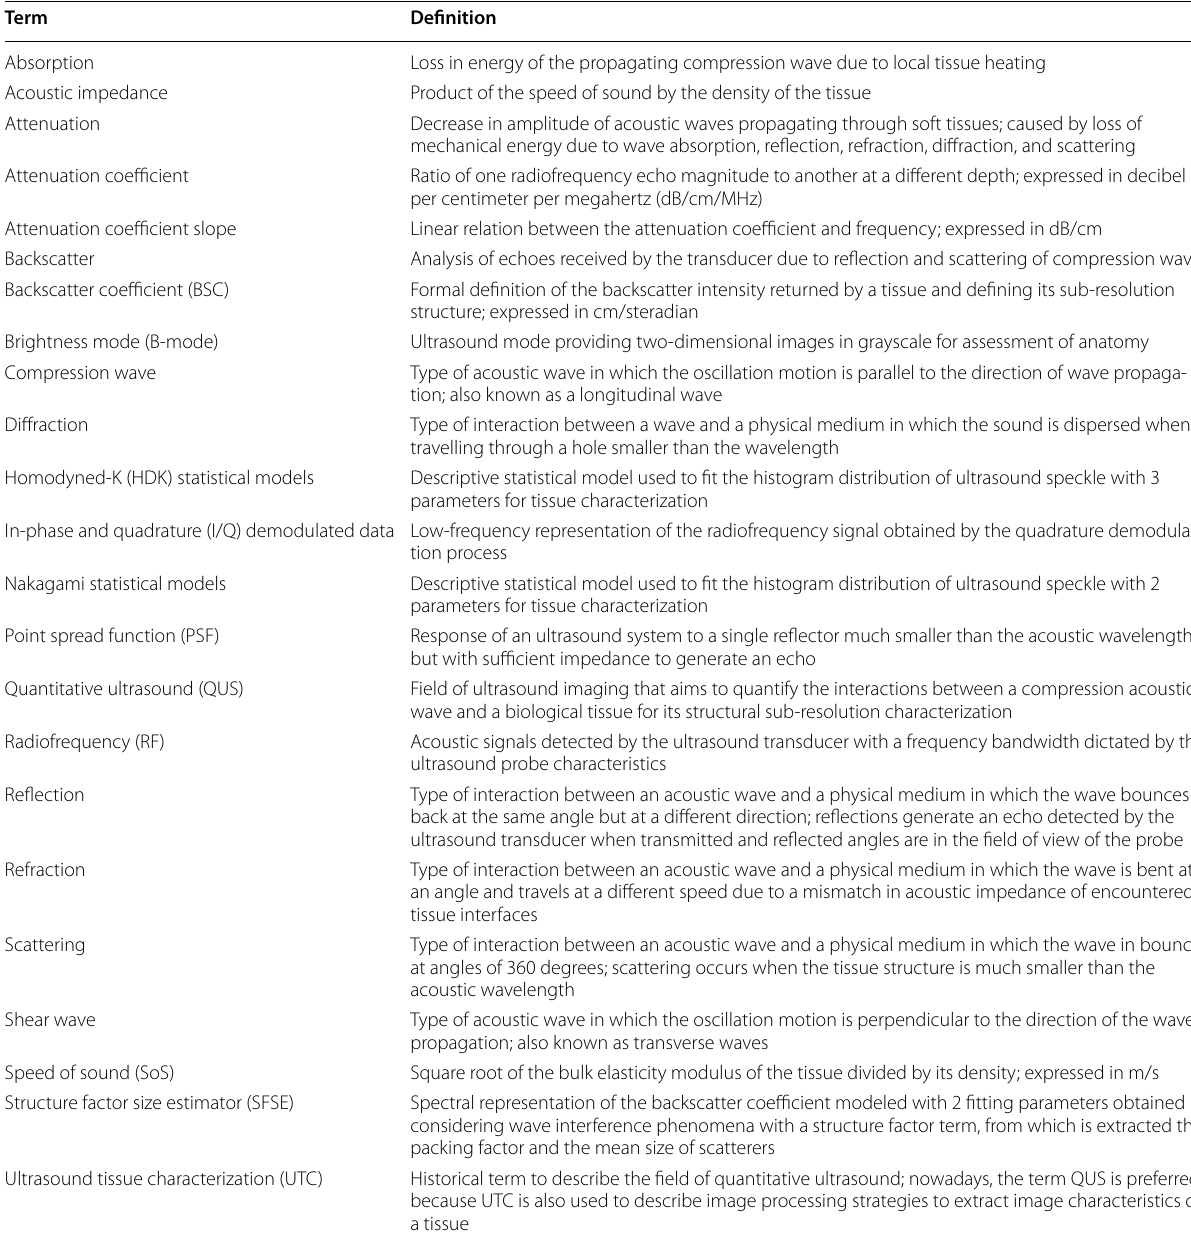
Table 1 Glossary of commonly used terms in quantitative ultrasound